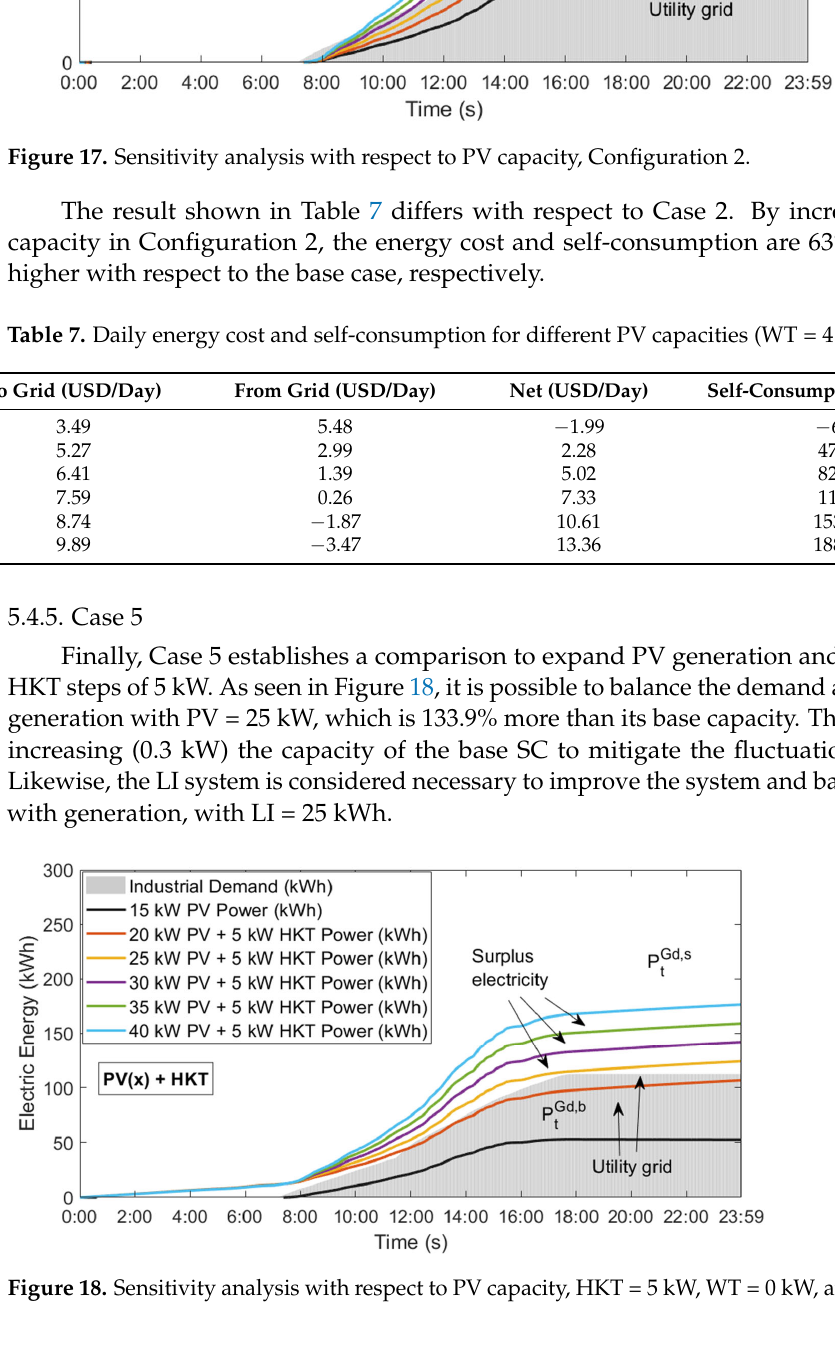
cost is 58.3% higher than the base case, and there is a 73.4% increase in self ‐ consumption.